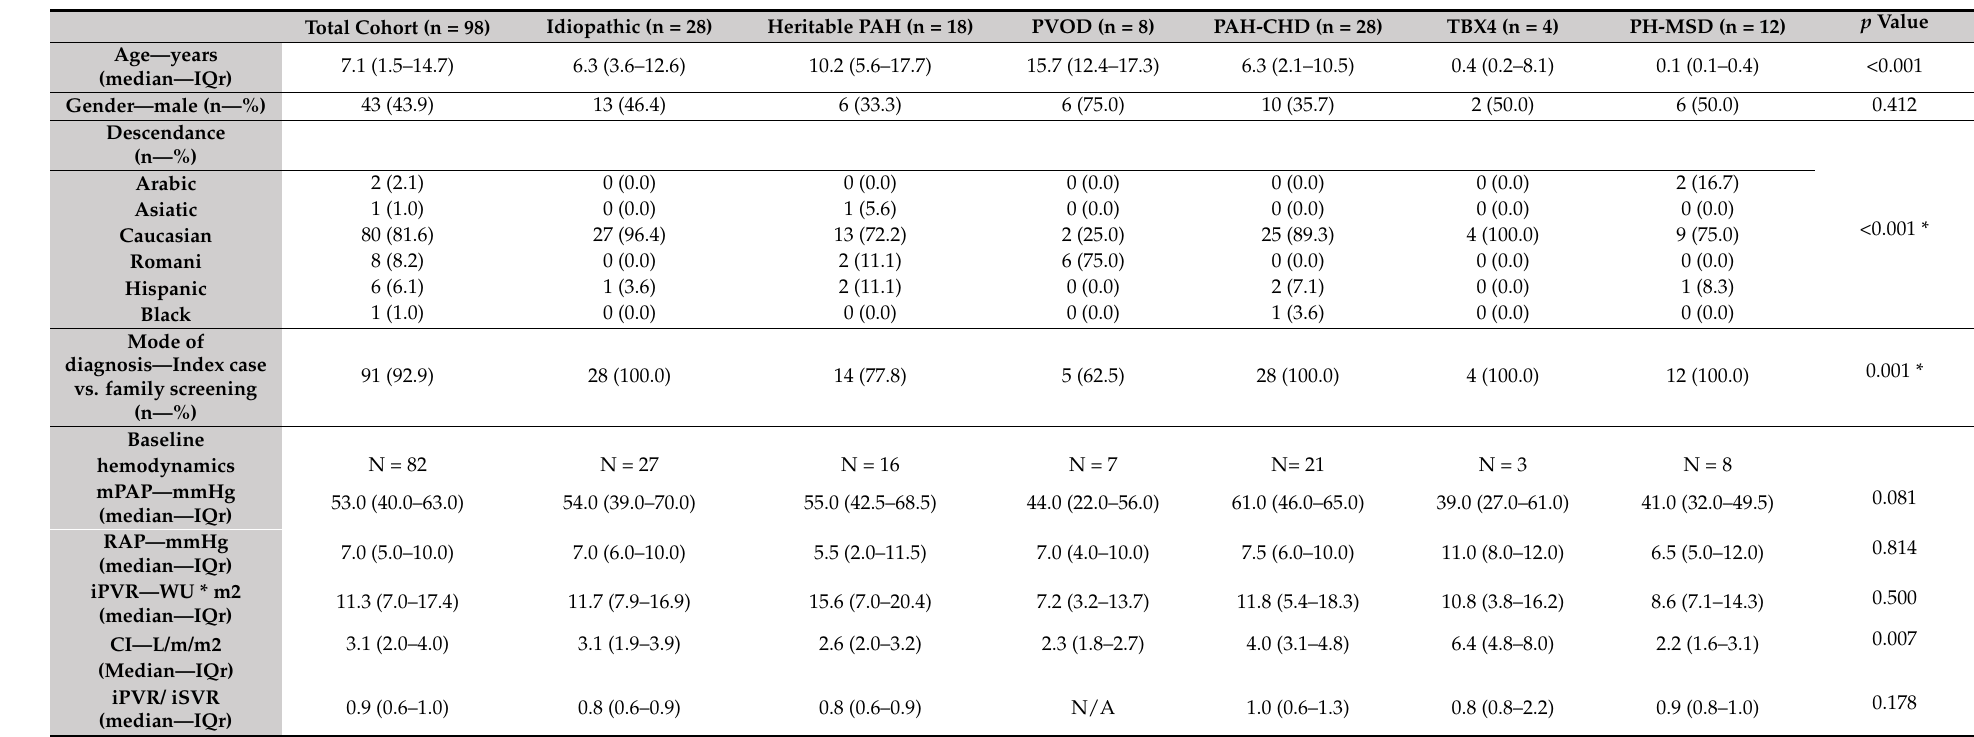
Table 1. Clinical, demographic and hemodynamical characteristics of the studied population. The clinical PH group shown in this table refers to the classification after genetic study. CI (cardiac index); DLD (developmental lung disease); IQr (interquartile range); iPVR (index pulmonary vascular resistance); iSVR (index systemic vascular resistance); mPAP (mean pulmonary artery pressure); N/A (not available); RAP (right atrial pressure); WU (Wood units). * p -value refers to global differences between